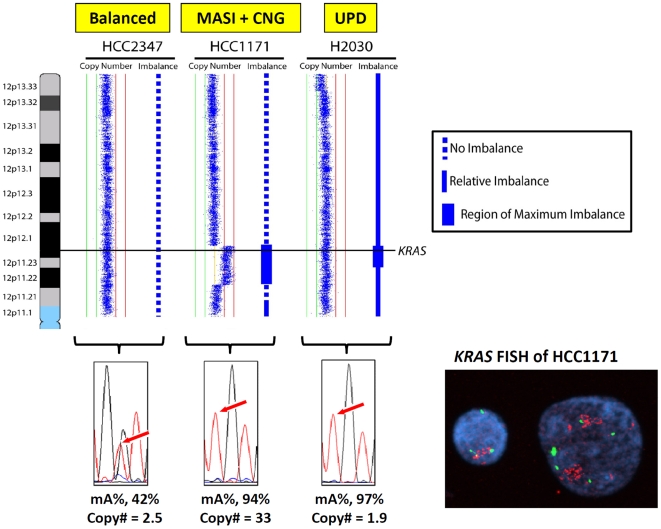

KRAS mutant allele specific imbalance (MASI) in lung cancer cell lines.(Left upper) Copy number and allelic imbalance status as determined by SNP 6.0 arrays are depicted for representative cell lines with balanced and MASI patterns of KRAS mutant/wild type allele ratios. For copy number, each blue dot represents an array element ordered by genomic position. Those shifted to the left of the middle line have decreased copy number whereas those shifted to the right have increased copy number. For allelic imbalance, dashed lines represent regions with no imbalance whereas solid lines represent those with imbalance. Thicker solid lines represent the region of maximum imbalance across the chromosome arm (see methods). The genomic location of KRAS is indicated by the horizontal black line. (Left lower) Electropherograms of direct DNA sequencing with mutant allele proportion (mA%, determined by electropherogram) and KRAS copy number (copy#, determined by quantitative PCR) are present in the same cell lines used for SNP arrays. (Right lower) KRAS FISH in HCC1171 was performed using purified DNA from BAC clone RP11-1119I8 encompassing the KRAS gene (red signal) and CEP12-SpectrumGreen (Abbott Molecular, IL) as an internal control. Means of KRAS copy number are 21.6±11.0 (standard deviation, SD) and those of CEP12 number are 3.7±1.2 (SD). Both SNP arrays and gene specific assays confirm that HCC2347 displays neutral KRAS copy number with no imbalance (mutant/wild type balanced) whereas HCC1171 and H2030 display imbalance (MASI) with copy number gain (CNG) or uniparental disomy (UPD), respectively.